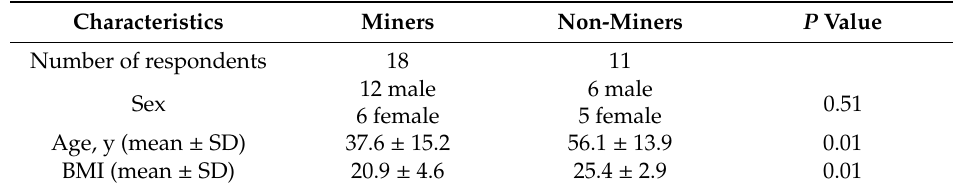
Table 1. Characteristics of the